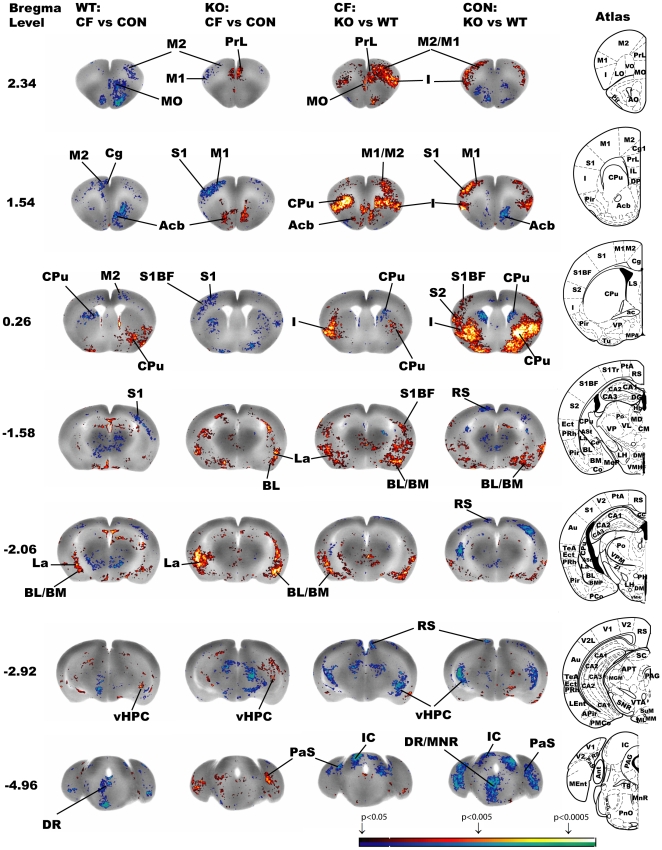
Changes in functional brain activity in mice in response to a fear conditioned tone.Depicted are select coronal slices (anterior-posterior coordinates relative to bregma) of the template brain. Colored overlays show statistically significant increased (red) and decreased (blue) differences for each comparison. Intragroup comparison were examined for fear conditioning with respect to the different genotypes (WT: CF vs. CON and KO: CF vs. CON) and genotype effects with respect to conditioning (CF: KO vs. WT and CON: KO vs. WT). Abbreviations are from Franklin and Paxinos mouse atlas [67]: Acb (accumbens nucleus), BL (basolateral amygdaloid nucleus), BM (basomedial amygdaloid nucleus), Cg (cingulate cortex), CPu (caudate putamen), DR (dorsal raphe nucleus), I (insular cortex), IC (inferior colliculus), La (lateral amygdaloid nucleus), M1 (primary motor cortex), M2 (secondary motor cortex), MnR (median raphe nucleus), MO (medial orbital cortex), PaS (parasubiculum), PrL (prelimbic cortex), RS (retrosplenial cortex), S1 (primary somatosensory cortex), S1BF (primary somatosensory, barrel field), S2 (secondary somatosensory cortex), ventral hippocampus (vHPC). Mouse brain atlas figures were reproduced from the mouse brain atlas [67] with modification and with permission from Elsevier.